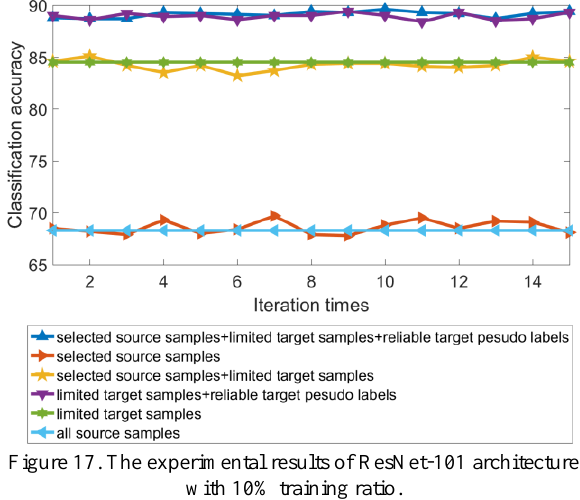
Figure 14. The experimental results of ResNet-18 architecture with 10% training ratio.